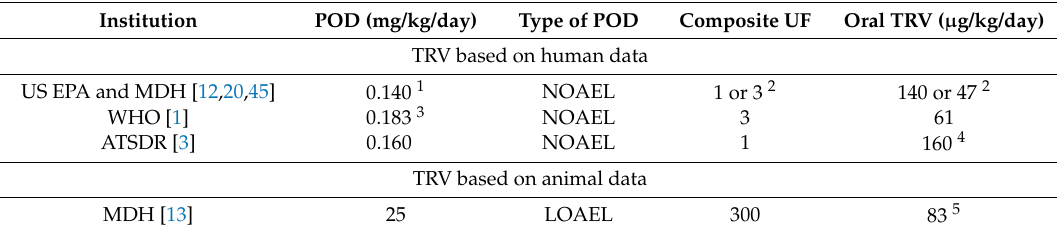
Table 1. Oral TRV recommended by various public health institutions.